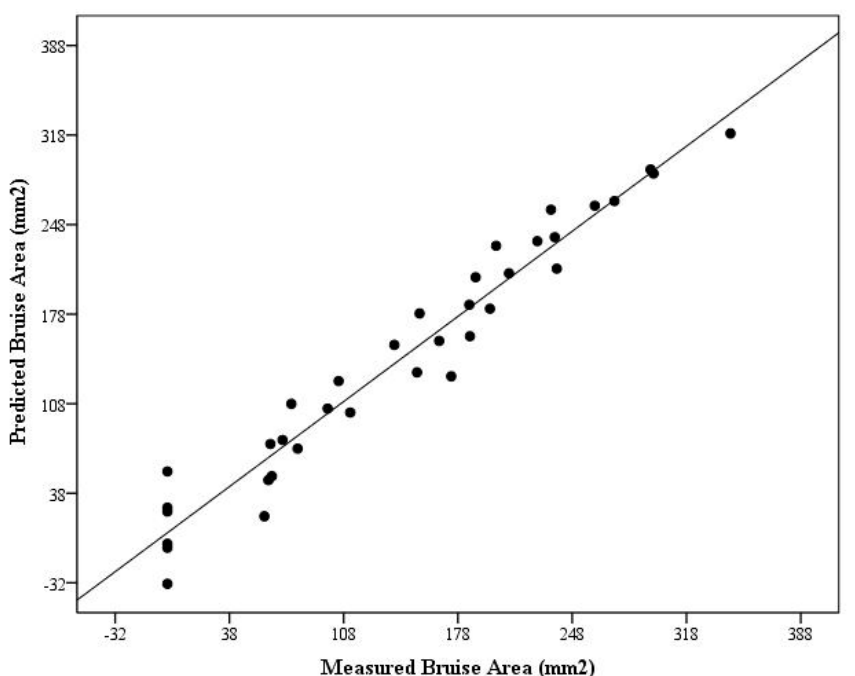
Figure 3. Results for the prediction of bruise area ( BA ) values based on linear regression models. Predicted BA versus measured BA (model 1).